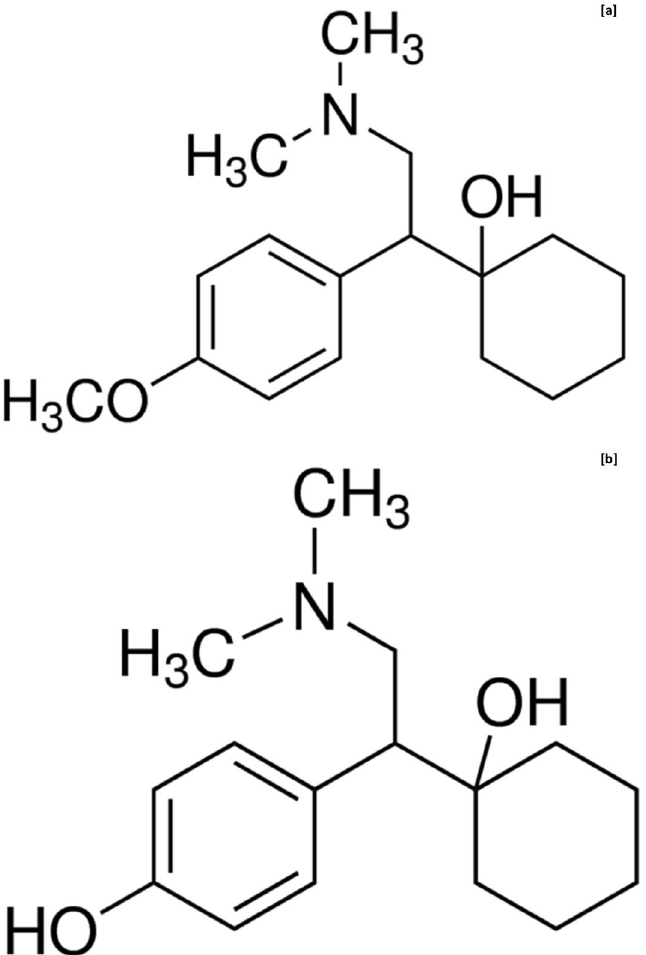
Figure 1. Chemical structure depiction of ( a ) venlafaxine and ( b ) O